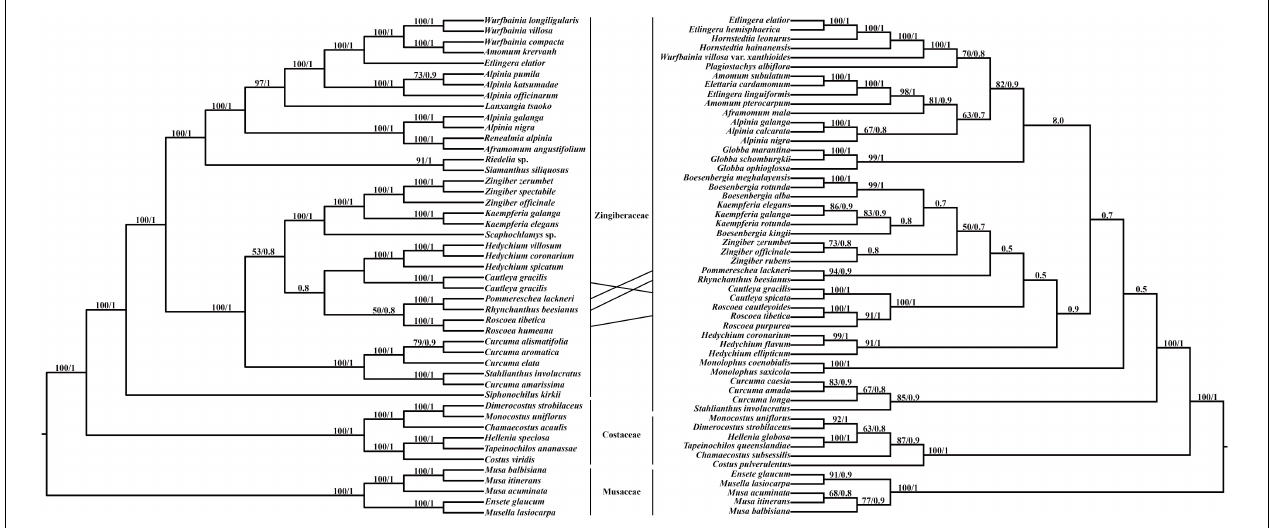
FIGURE 4 | The phylogenetic tree ML (maximum likelihood) and BI (Bayesian Inference) based on 47 complete chloroplast genomes (left) and 54 ITS (internal transcribed spacer) sequences (right). Supporting values of > 50% and > 0.5 for ML and BI, respectively, were shown on the branch.